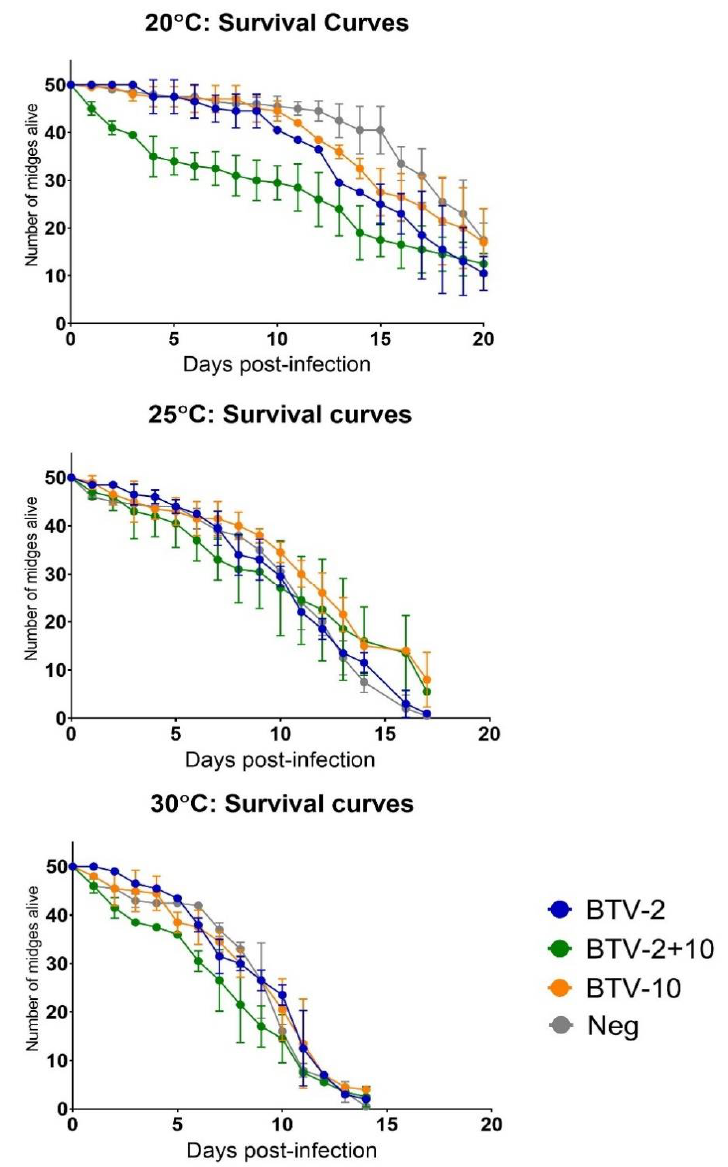
Figure 5. Survival of C. sonorensis at different temperatures. Survival groups (n = 50 per group) were infected in duplicate with the virus via blood meal (BTV-2, BTV-10, BTV-2+10 or negative) at the same titers as experimental groups. Survival groups were held at the respective temperatures (20, 25 or 30 °C) for the duration of the experiment and the number of surviving midges for each group was counted daily. Error bars depict the range at each time point.